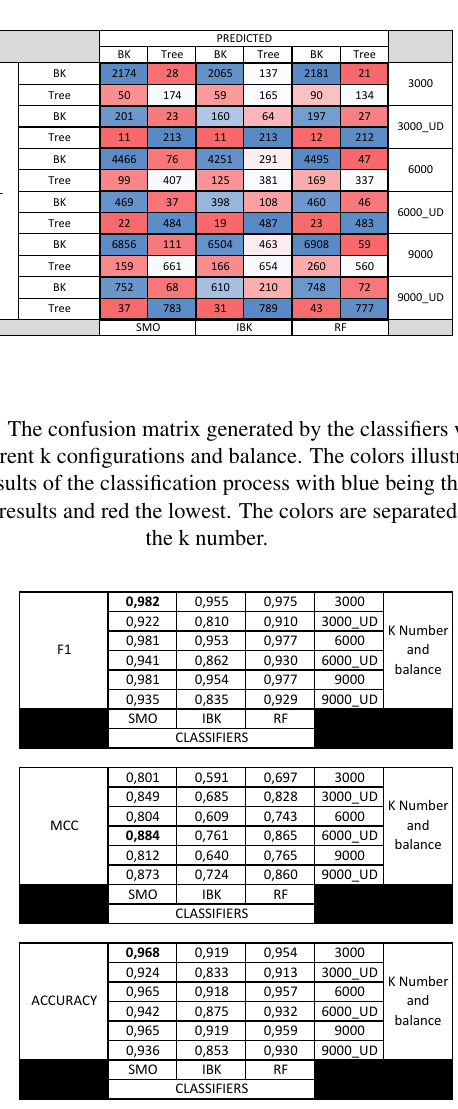
Figure 5. This figure shows the results of the derivations of the confusion matrix generated in this paper. F1 is the harmonic mean of precision and sensitivity. The Matthews correlation coefficient (MCC) is used in machine learning as a measure of the quality of binary (two-class) classifications, and the accuracy refers to closeness of the measurements to a specific value the F-measure results that the background in general had greater relevance than the tree